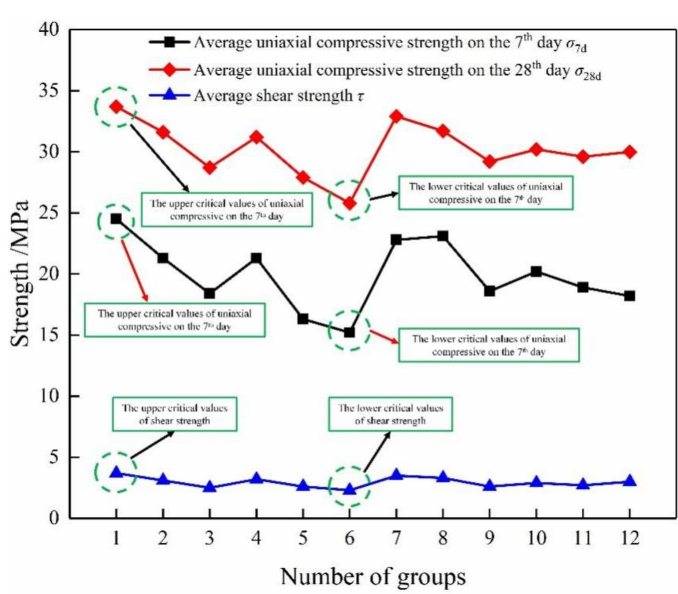
Figure 14. Mechanical strength of